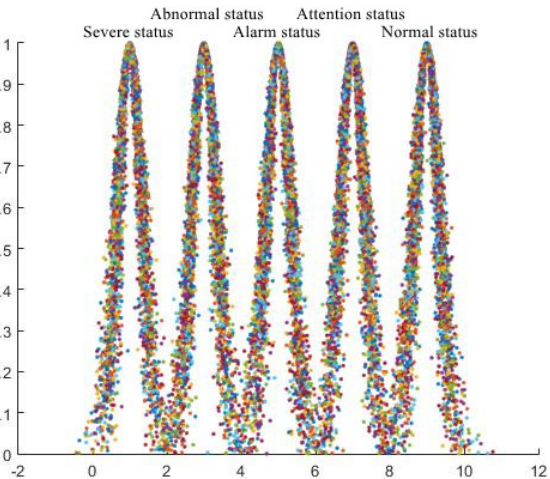
Figure 5. Regulation layer dynamic index evaluation cloud (the digital eigenvalues of cloud models, including each evaluation level, are calculated by the forward cloud generator, and the number of raindrops is set to 𝑛 = 5000).